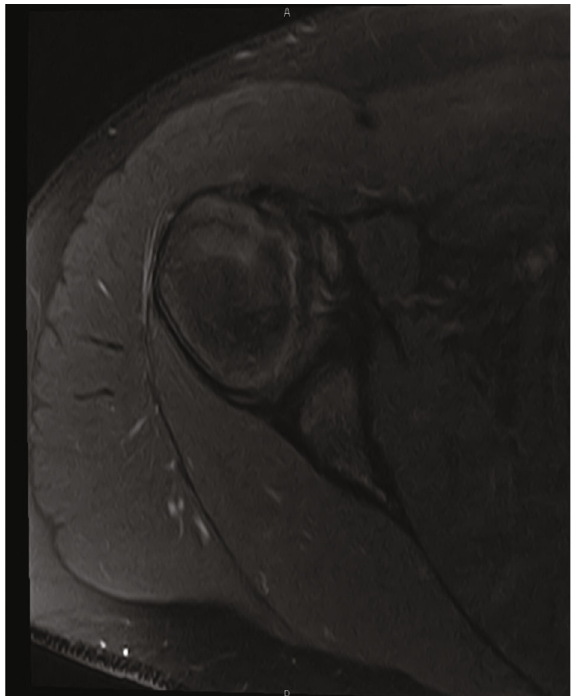
Figure 3: Axial proton density fat saturation image demonstrating the nonunited lesser tuberosity fragment without surrounding edema.